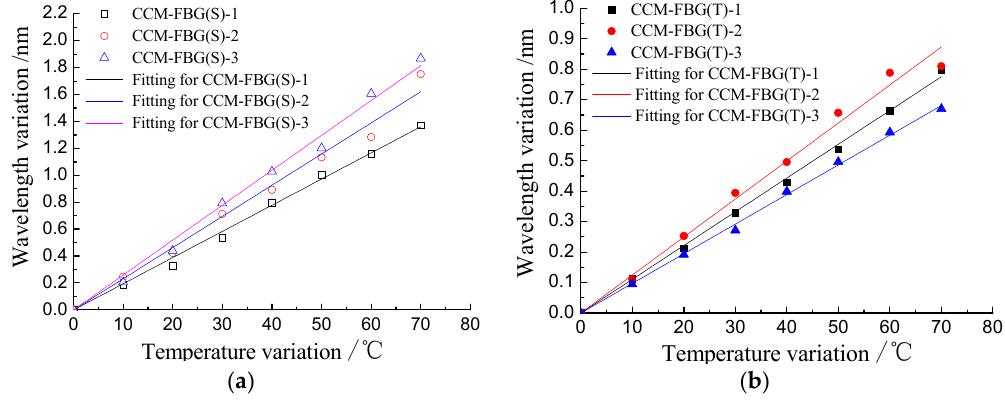
Figure 7. Calibration results of temperature for CCM-FBG: ( a ) CCM-FBG (S); ( b ) CCM-FBG (T).